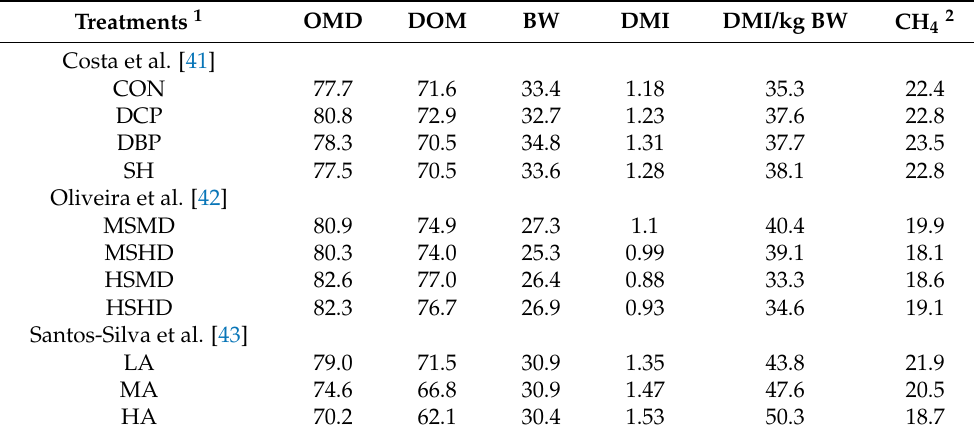
Table 4. Apparent organic matter digestibility (OMD, %) and digestible organic matter (DOM, % dry matter) of the diets at maintenance feeding level, body weight (BW, kg), dry matter intake